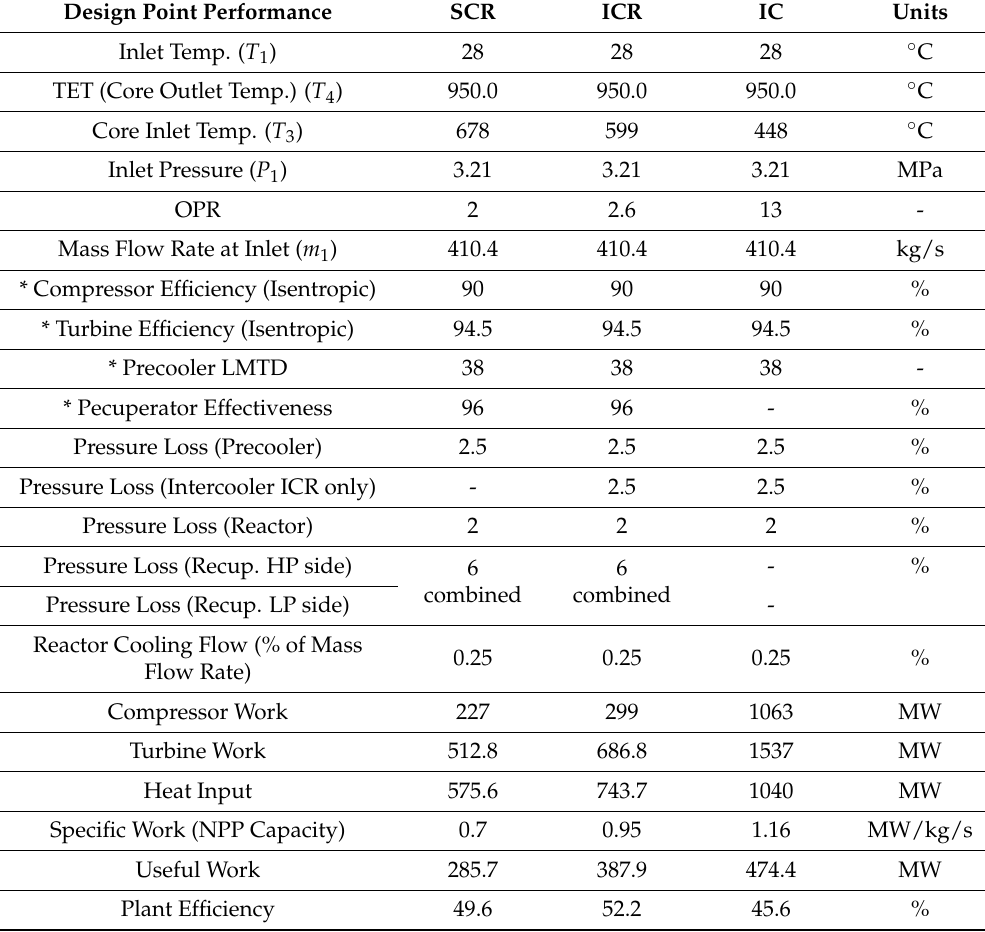
Table 1. Design Point Input Values for